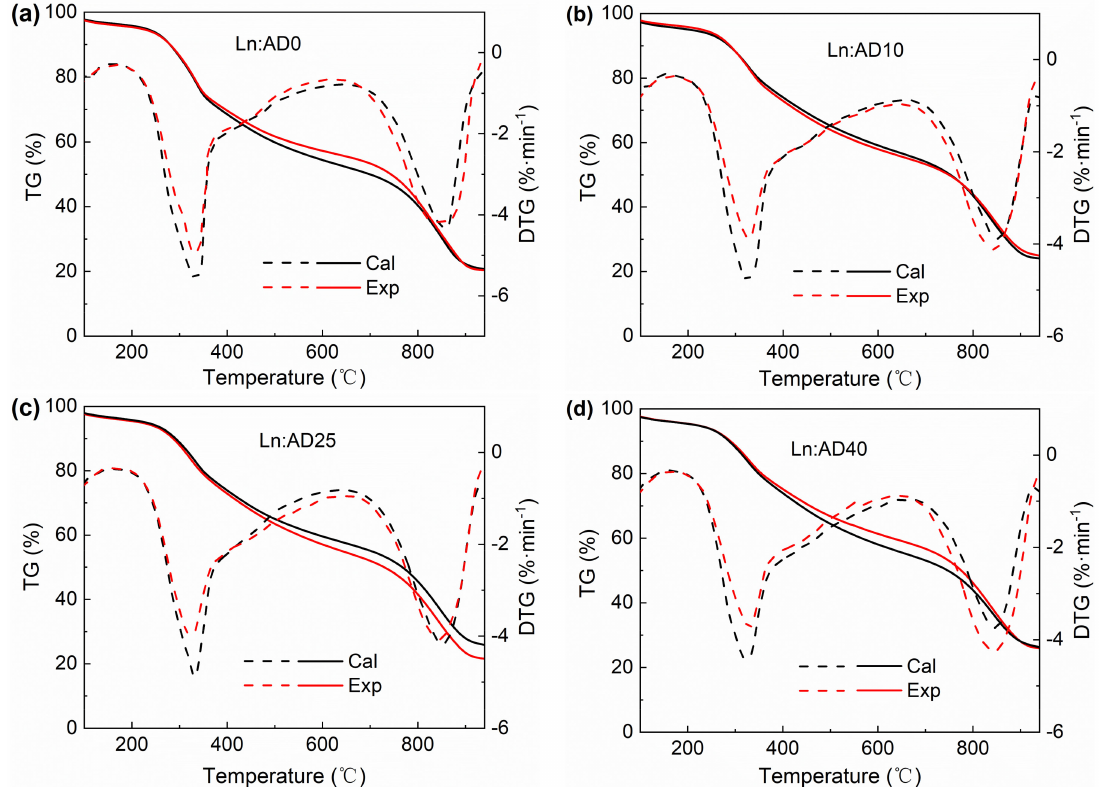
Figure 4. Experimental and the calculated TG, DTG curves of lignite and digestate with ( a ) AD 0 day, ( b ) AD 10 days, ( c ) AD 25 days and ( d ) AD 40 days at the ratio of 50:50% ( wt / wt